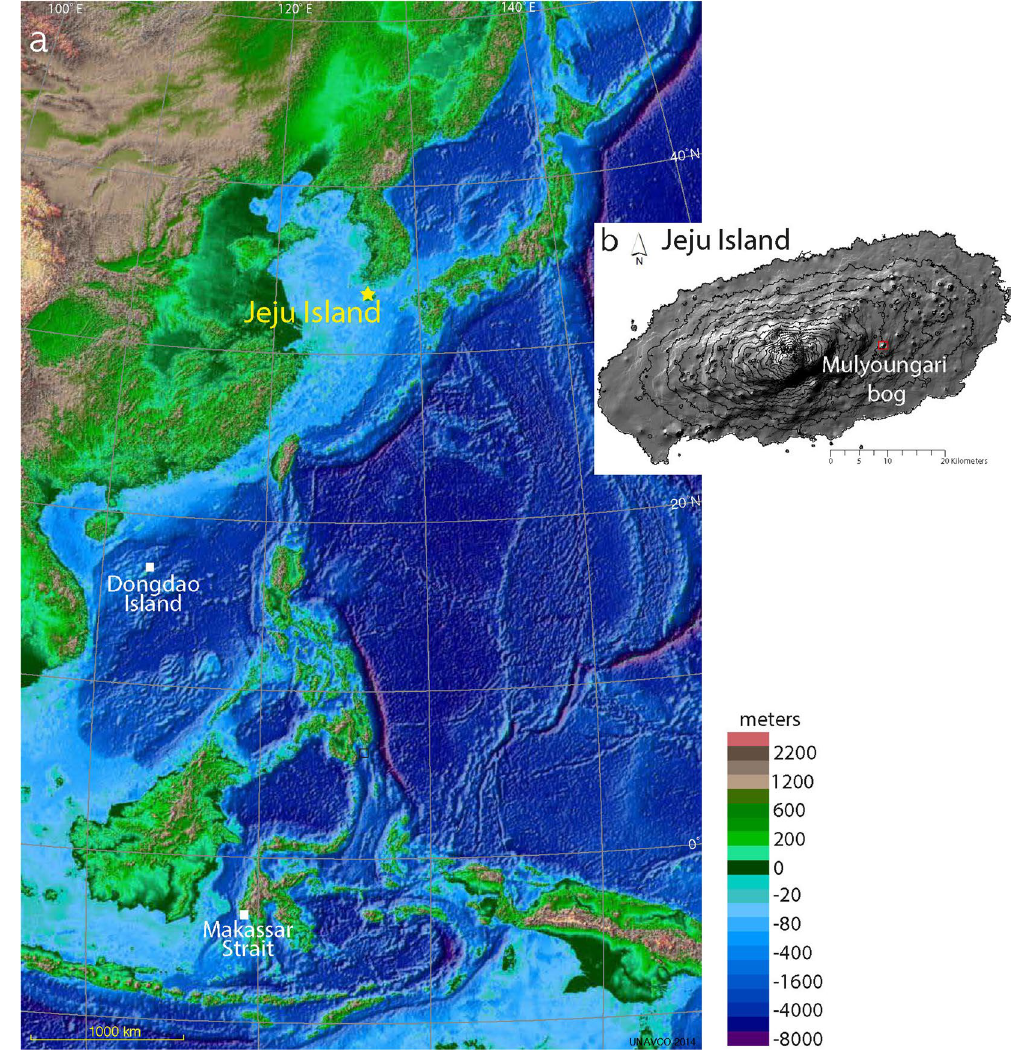
Figure 1. ( a ) Locations of the study site and paleoclimate records used in this study: Macassar Strait, Indonesia 60 and Dongdao Island in South China Sea 59 (see Fig. 4c,d). This map was modified from the UNAVCO Jules Verne Voyager (UNAVCO Inc., jules.unavco.org) based on Generic Mapping Tools (GMT-5; gmt.soest.hawaii.edu) ( b ) Location of the Mulyounari swamp in Jeju Island. The contour map was generated using software ArcGIS 10.1